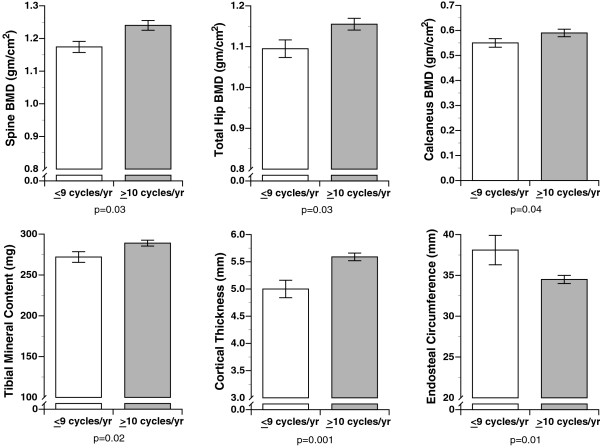
The impact of menstrual function on bone mass and size. Menstrual function was defined as normal (≥ 10 cycles/year) versus oligomenorrhea/amenorrhea (≤ 9 cycles/year). Bone mineral density was measured at the spine, hip and heel; and at the tibia, bone mineral content, cortical thickness and endosteal circumference were determined. All values are mean ± standard errors.